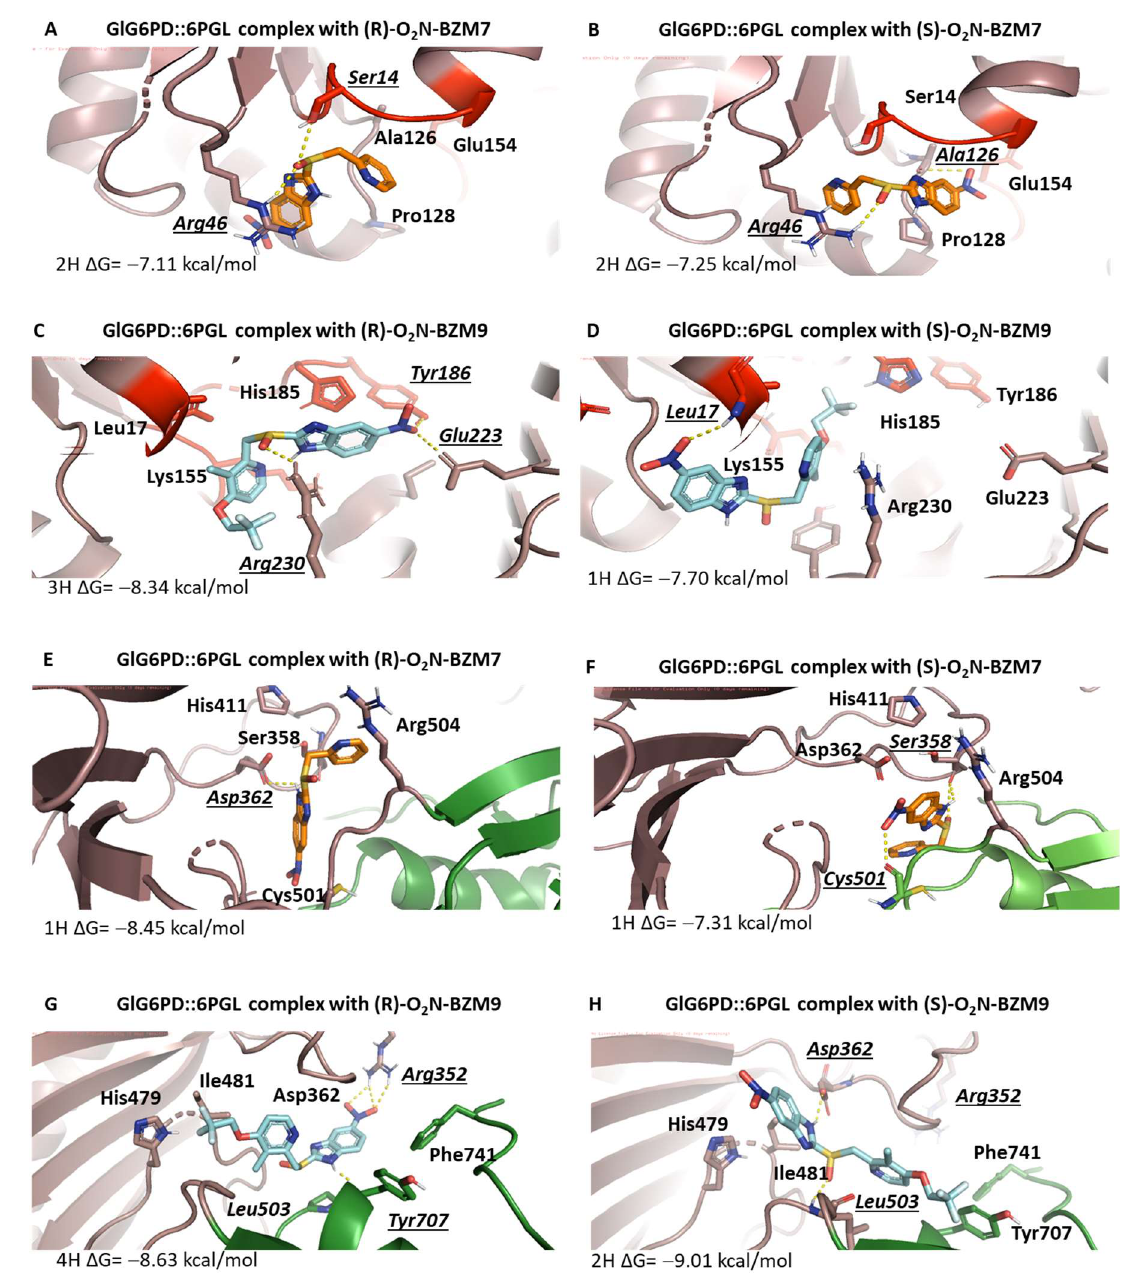
Figure 8. Interaction zones of the chemical compounds O 2 N-BZM7 and O 2 N-BZM9 on the GlG6PD::6PGL protein. ( A ) Interaction between the residues of the NADP + catalytic site of GlG6PD::6PGL in the presence of ( R )- O 2 N-BZM7 , ( B ) ( S )- O 2 N-BZM7, ( C ) ( R )- O 2 N-BZM9, and ( D ) ( S )- O 2 N-BZM9 . ( E ) Interaction between the residues of the NADP + structural site of GlG6PD::6PGL in the presence of ( R )- O 2 N-BZM7 , ( F ) ( S )- O 2 N-BZM7 , ( G ) ( R )- O 2 N-BZM9 , and ( H ) ( S )- O 2 N-BZM9 . The O 2 N-BZM7 and O 2 N-BZM9 compounds are shown in orange and light blue, respectively. H-bonds are represented in italic and underlined.